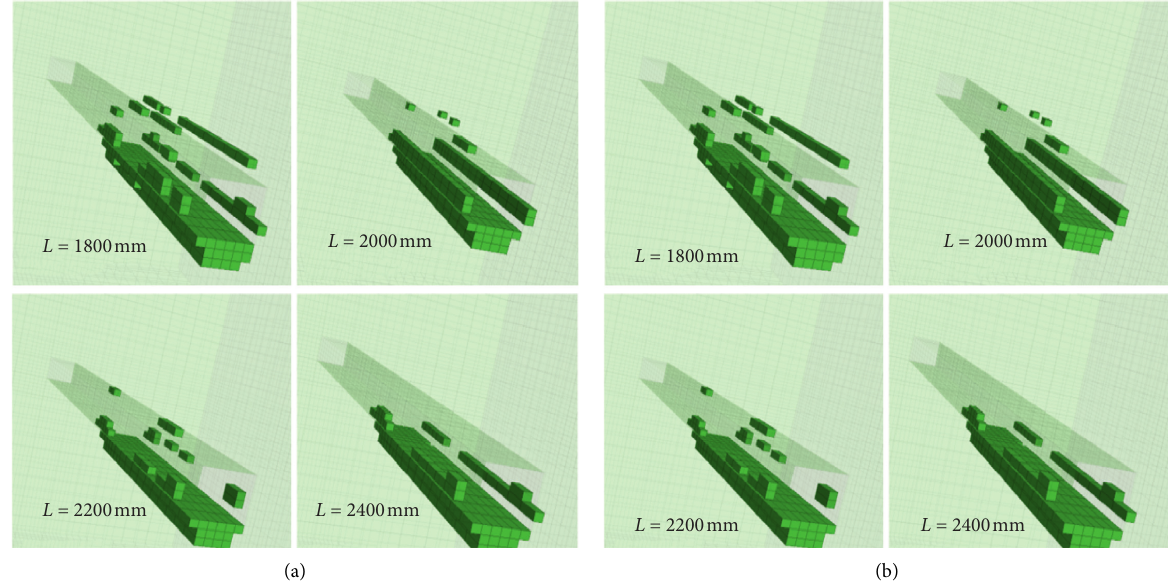
Figure 6: Roadway tensile failure distribution with different bolt lengths: (a) T � 0s; (b) T � 0.1 s.